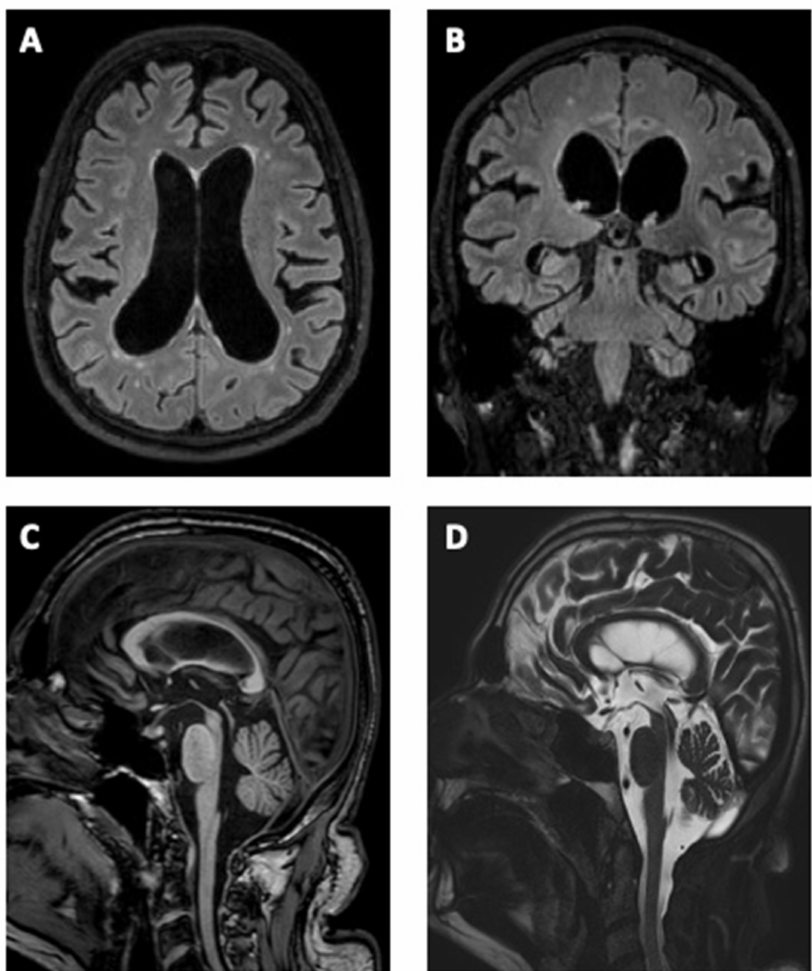
Figure 1. Brain MRI of the typical morphological changes associated with idiopathic normal pressure hydrocephalus and progressive supranuclear palsy. ( A ) Axial Flair, ventriculomegaly with an Evan’s index of more than 0.3, enlargement of lateral and third ventricles with a widening of the temporal horns, and mild T2 hyperintensities in the periventricular and deep white matter. ( B ) Coronal Flair, disproportionately enlarged subarachnoid spaces, tight high convexity (narrow sulci and subarachnoid spaces at the vertex and medial/parafalcine region) accompanied by enlargement of the inferior cerebrospinal fluid (CSF) spaces, particularly in the Sylvian fissures. The callosal angle measured at the level of posterior commissure is typically less than 80 ◦ . ( C ) Sagittal T1, midbrain atrophy (penguin or hummingbird sign), thinning and upward bowing of the corpus